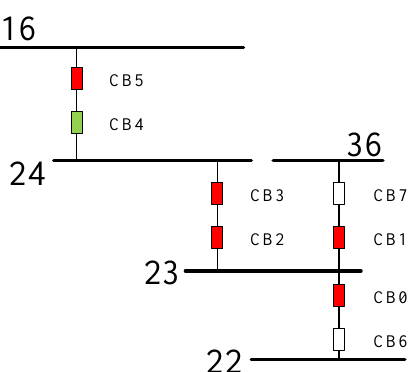
Figure 15. Double faults of the IEEE 39-bus system.